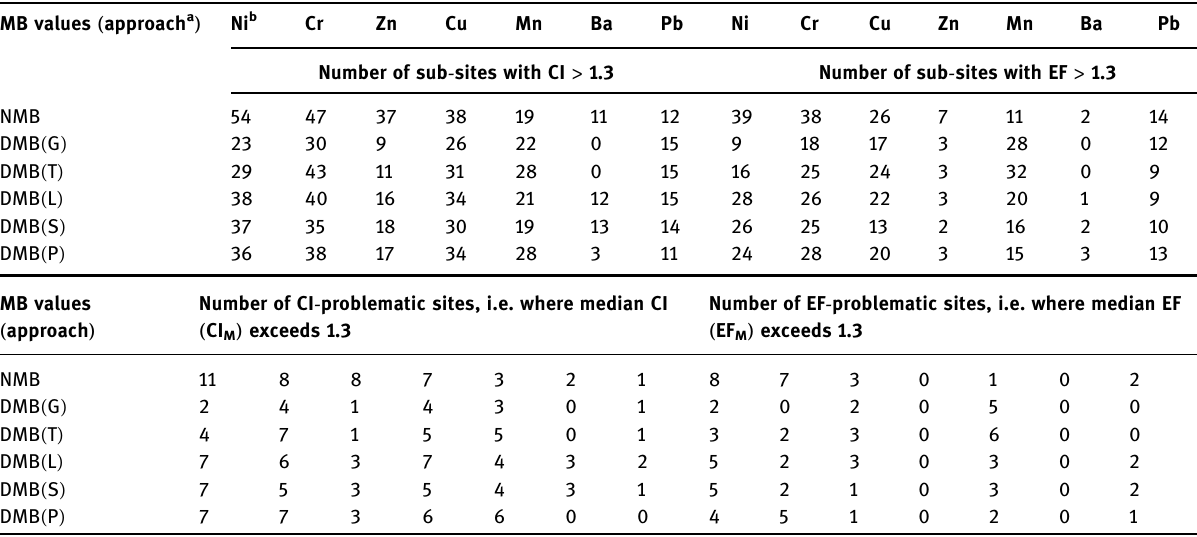
Table 8: In fl uence of MB values on the number of sub - sites and sites with elevated assessment indices MB values ( approach a